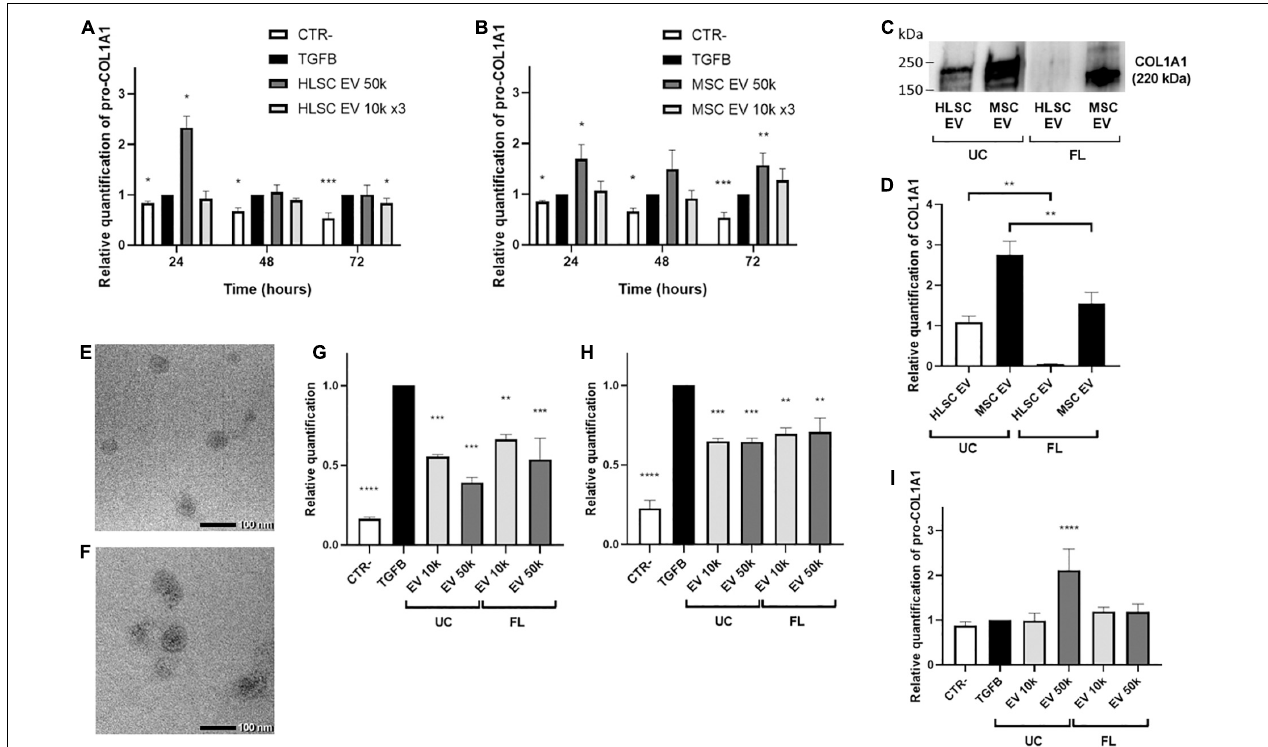
FIGURE 4 | EV effect on the release of pro-collagen I alpha-1 by LX-2. (A,B) Pro-COL1A1 levels were measured using ELISA human pro-COL1A1 assay in the supernatant of LX-2 stimulated for 24–48–72 h with HLSC-EVs (A) or MSC-EVs (B) . (C,D) Representative image (C) and protein bands quantification (D) of western blot analysis of COL1A1 protein in HLSC-EVs and MSC-EVs isolated by ultracentrifugation (UC) and by floating (FL). The COL1A1 band intensity in UC-HLSC-EVs was used as reference control. (E,F) Representative micrographs of transmission electron microscopy of FL-HLSC-EVs (E) and FL-MSC-EVs (F) . EVs were negatively stained with NanoVan (scale bar, 100 nm; magnification, 100,000 × ). (G,H) QRT-PCR analysis of the expression of α -SMA (G) and COL1A1 (H) genes in LX-2 after a 24-h incubation with UC-HLSC-EVs and FL-HLSC-EVs (10–50 k). Gene expression levels were normalized on those of the housekeeping gene TBP. (I) Pro-COL1A1 levels measured in the supernatant of LX-2 stimulated for 24 h with UC-HLSC-EVs and by FL-HLSC-EVs (10–50 k). For all experiments, LX-2 activated with TGF- β 1 (10 ng/mL) not incubated with EVs were used as reference control. LX-2 cultured without TGF- β 1 were used as negative control (CTR-). Statistical analysis was performed on results obtained from at least three independent experiments using the One-way or the Two-way ANOVA test: * p < 0.05; ** p < 0.01; *** p < 0.001; **** p <